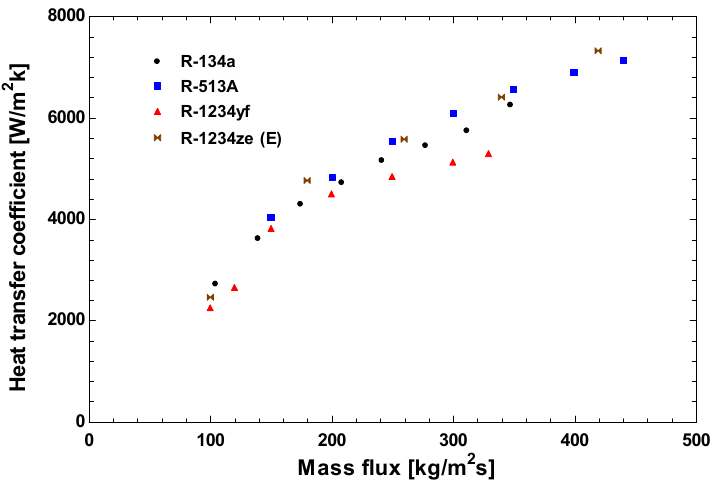
Figure 6. Refrigerant-side heat transfer coefficients with variation of the refrigerant mass flux.